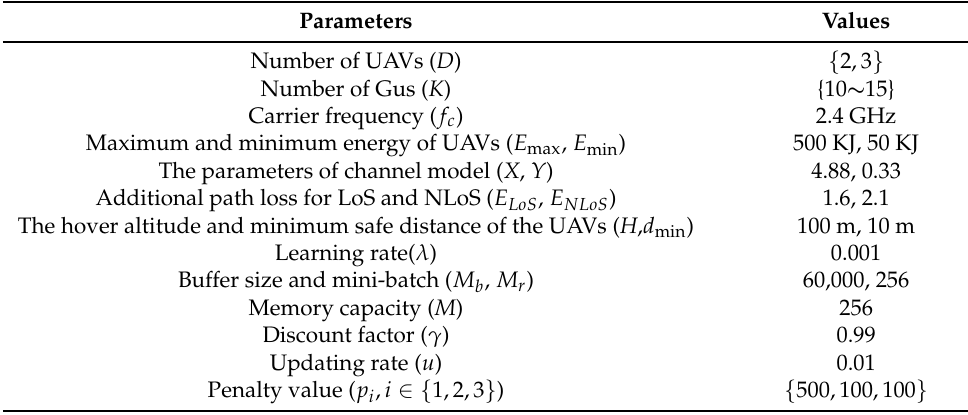
Table 2. Simulation Settings. Parameters Values Number of UAVs ( D ) { 2,3 } Number of Gus ( K ) {10 ∼ 15} Carrier frequency ( f c ) 2.4 GHz Maximum and minimum energy of UAVs ( E max , E min ) 500 KJ, 50 KJ The parameters of channel model ( X , Y ) 4.88, 0.33 Additional path loss for LoS and NLoS ( E LoS , E NLoS